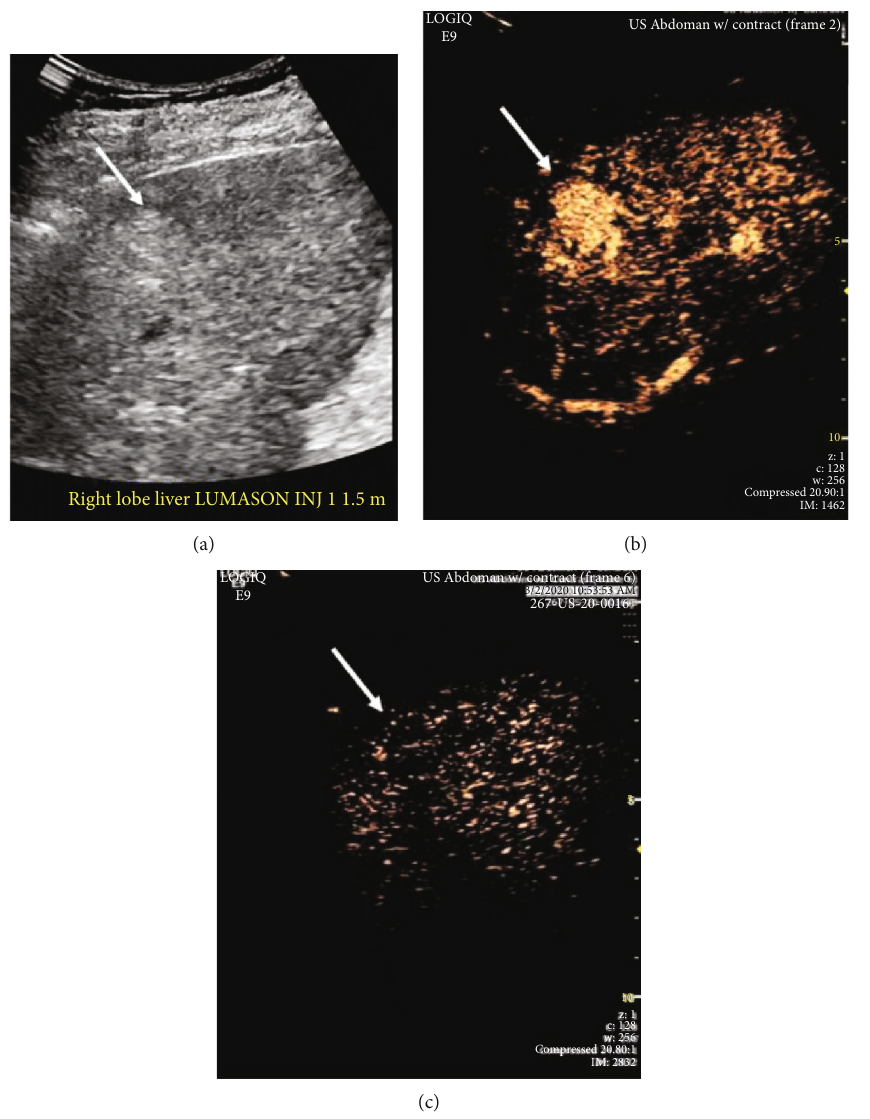
Figure 2: Contrast-enhanced ultrasound (US) demonstrates a 2.5cm mass in segment 7 (arrow) that is echogenic on grayscale (a) and has early enhancement relative to the liver parenchyma (b). At 5 minutes postcontrast injection, there is a very subtle washout